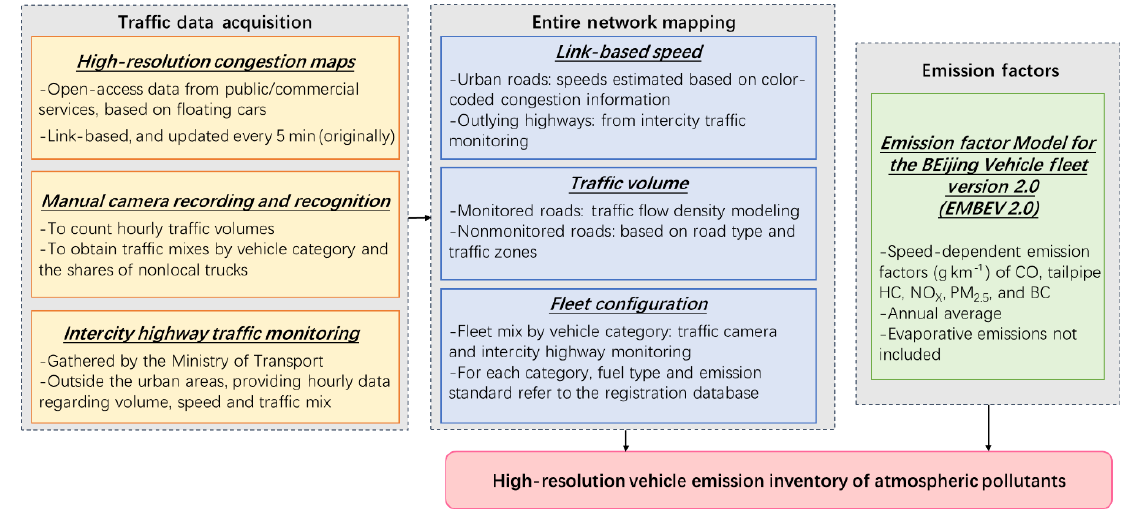
Figure 1. A system diagram of the modeling methodology for EMBEV-Link.